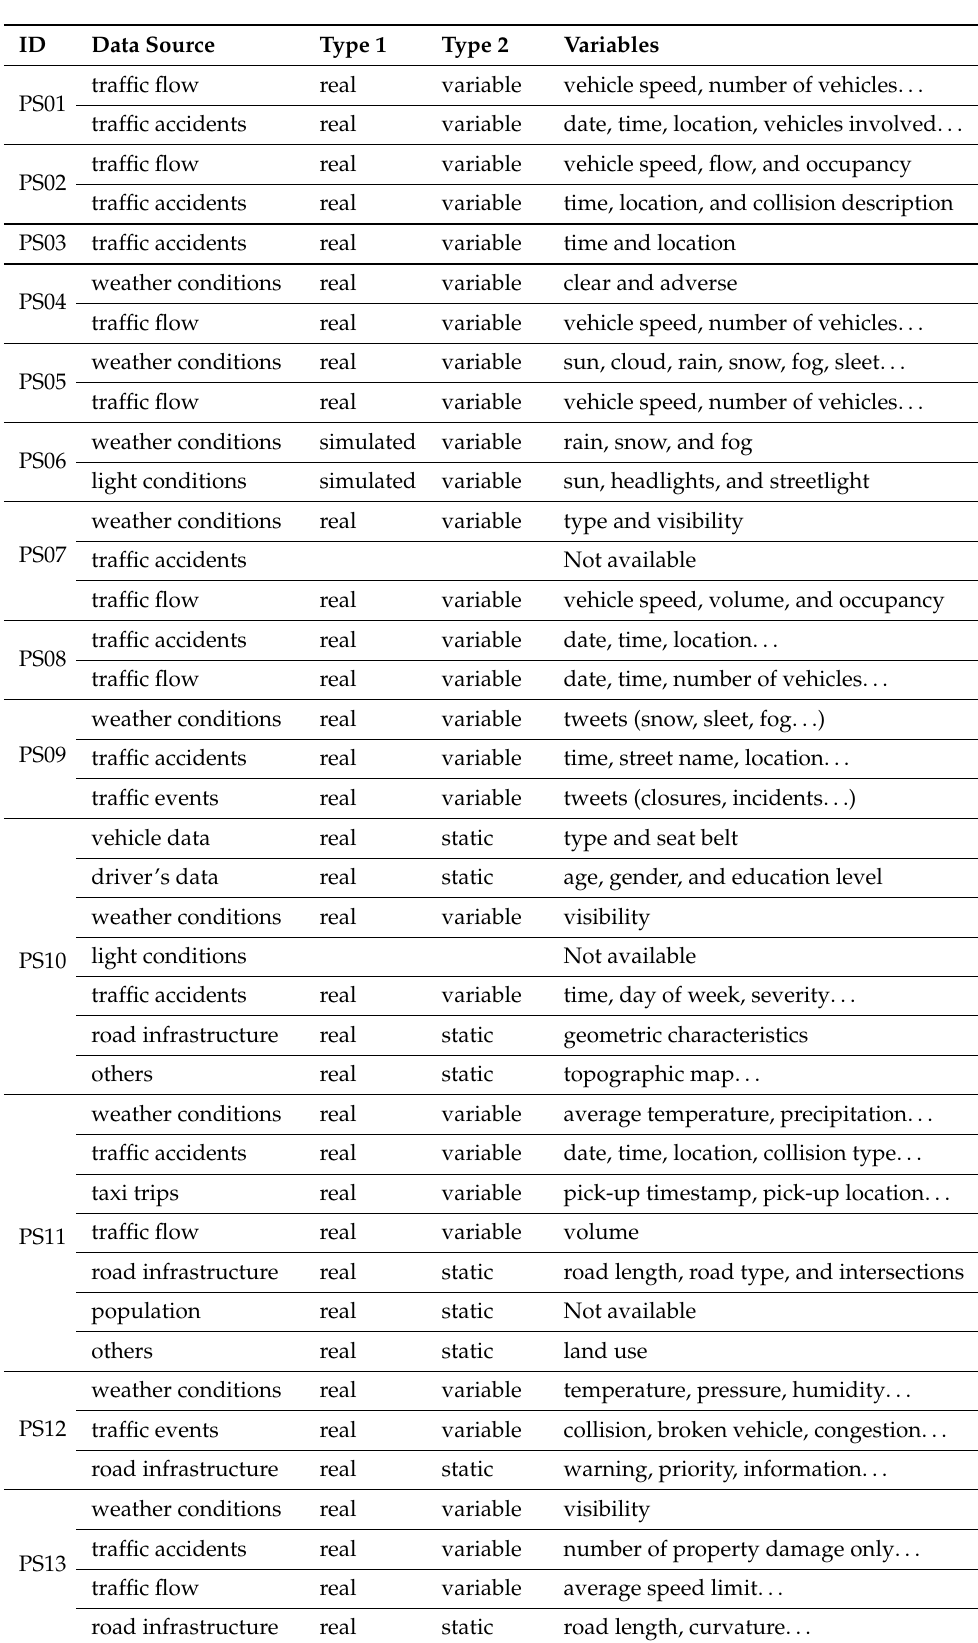
Table A2. Features